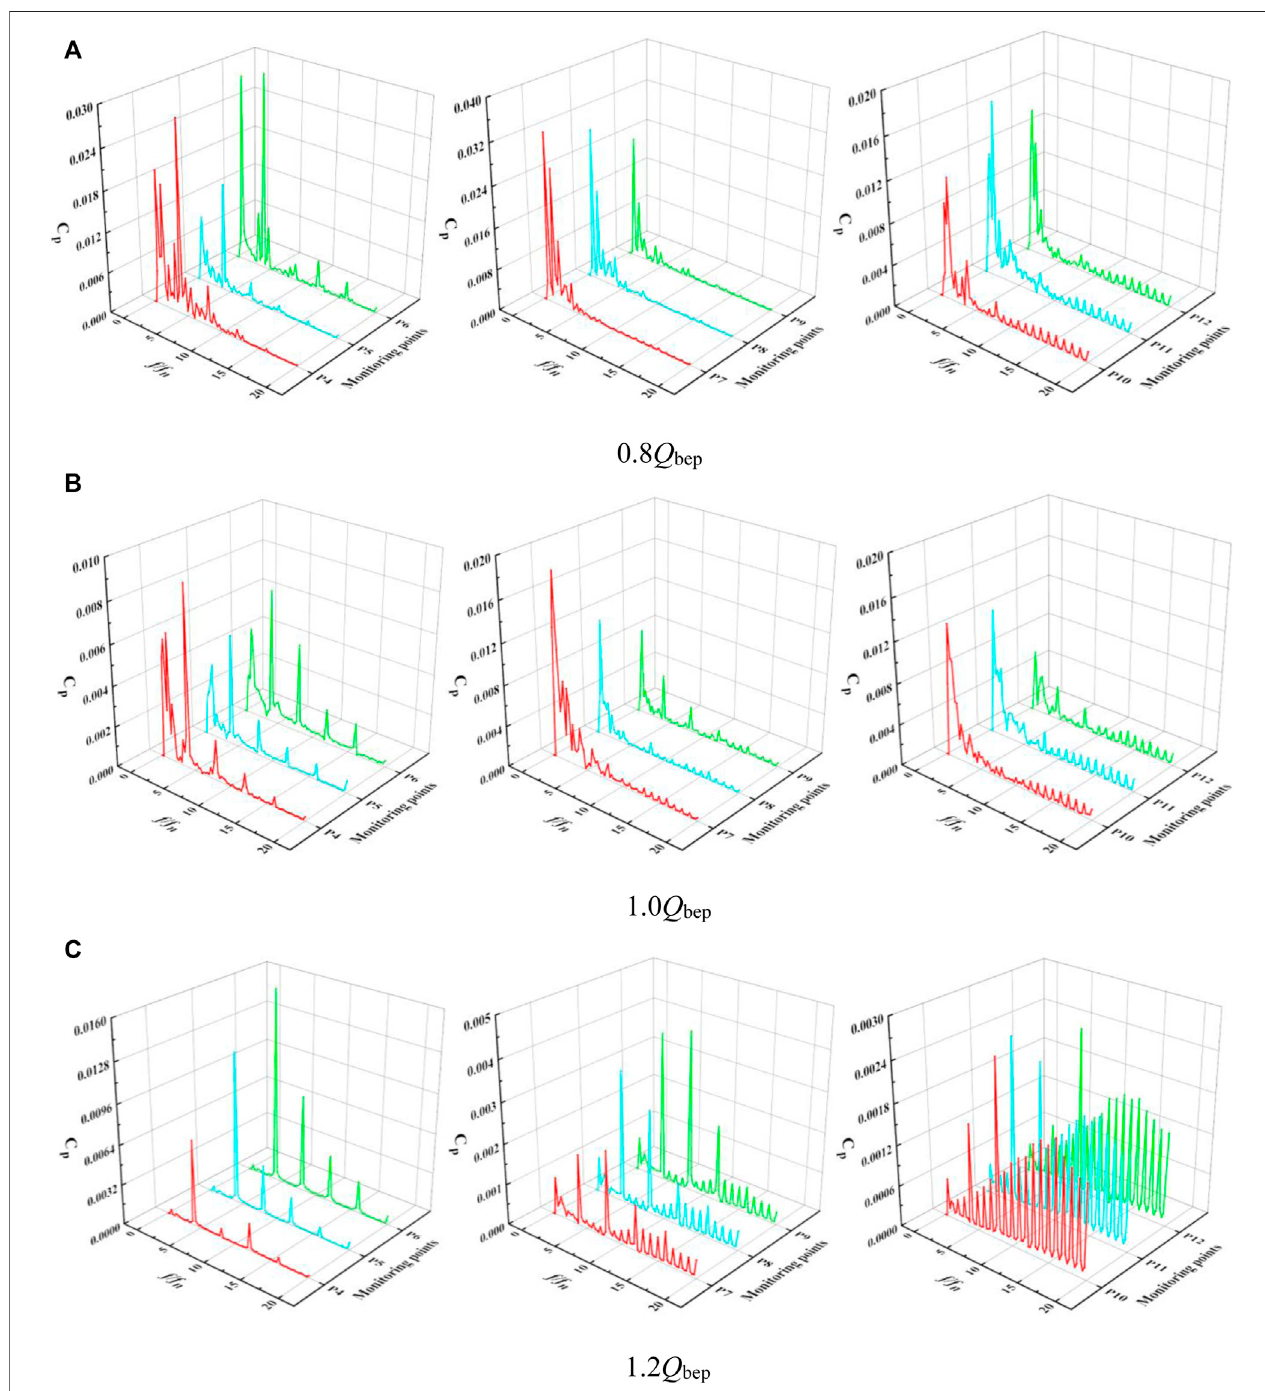
FIGURE 18 | Frequency domain diagram of pressure pulsation in guide